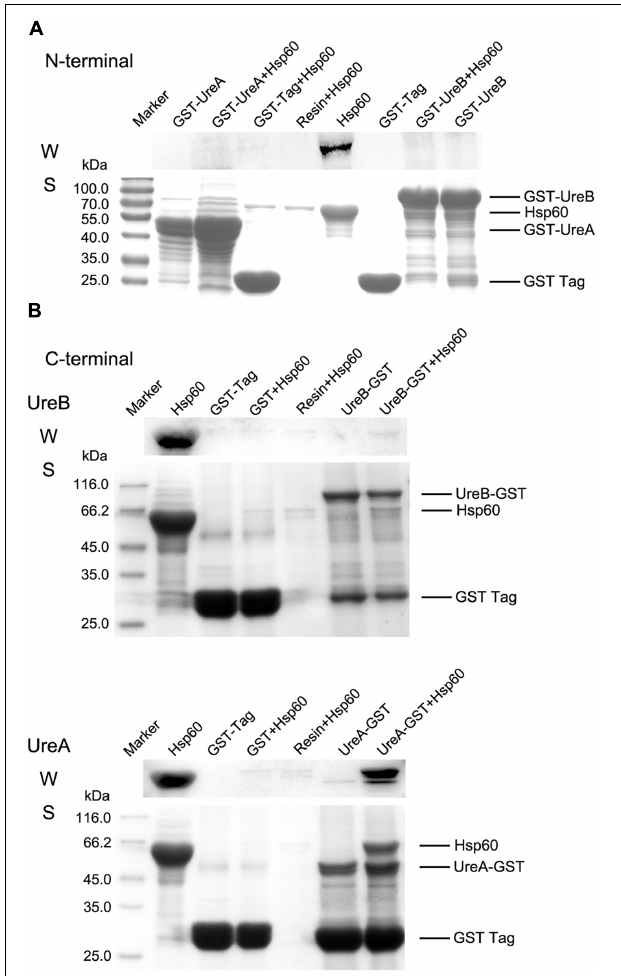
FIGURE 3 | Pull-down assay. (A) Results of GST pull-down assay to detect the interaction of GST-UreA and GST-UreB with Hsp60. (B) The interaction of Hsp60 with UreA-GST or UreB-GST was verified individually. All pull-down assays were performed as follows: 20 µ l of glutathione Sepharose 4B beads saturated with GST-fused proteins were incubated with 0.4 ml of Hsp60 (1 mg/ml dissolved in 50 mM Tris-HCl, pH 8.0) at 4 ◦ C for 2 h. The pellets were washed four times and resuspended in SDS-PAGE sample buffer for Western blotting (W) and SDS-PAGE (S) analysis. Hsp60 co-incubated with GST-tag immobilized beads and empty beads were used as negative controls. Purified Hsp60 was used as a positive control. Anti-His antibody was used to detect the bound Hsp60 and horseradish peroxidase (HRP)-conjugated goat anti-mouse IgG 158 was used to detect the primary antibody. All experiments were repeated at least three